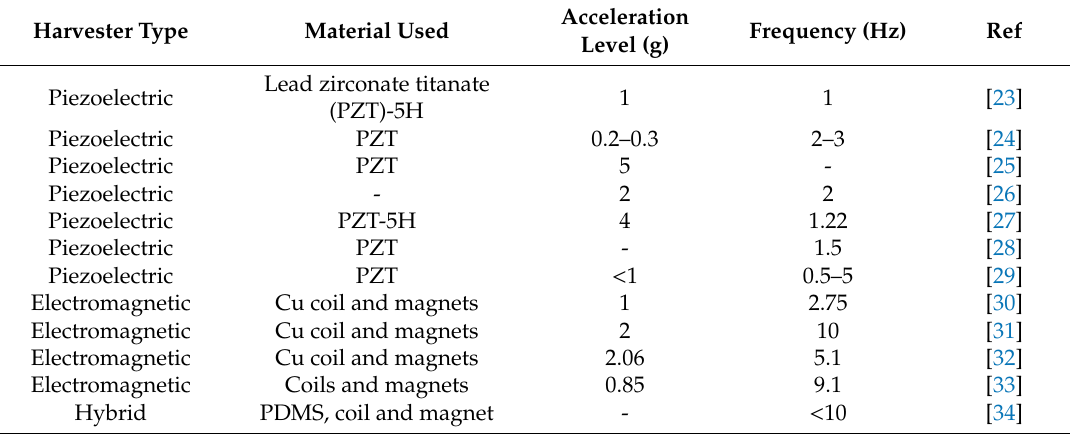
Table 2. Literature summary of the frequency and acceleration levels at shoe